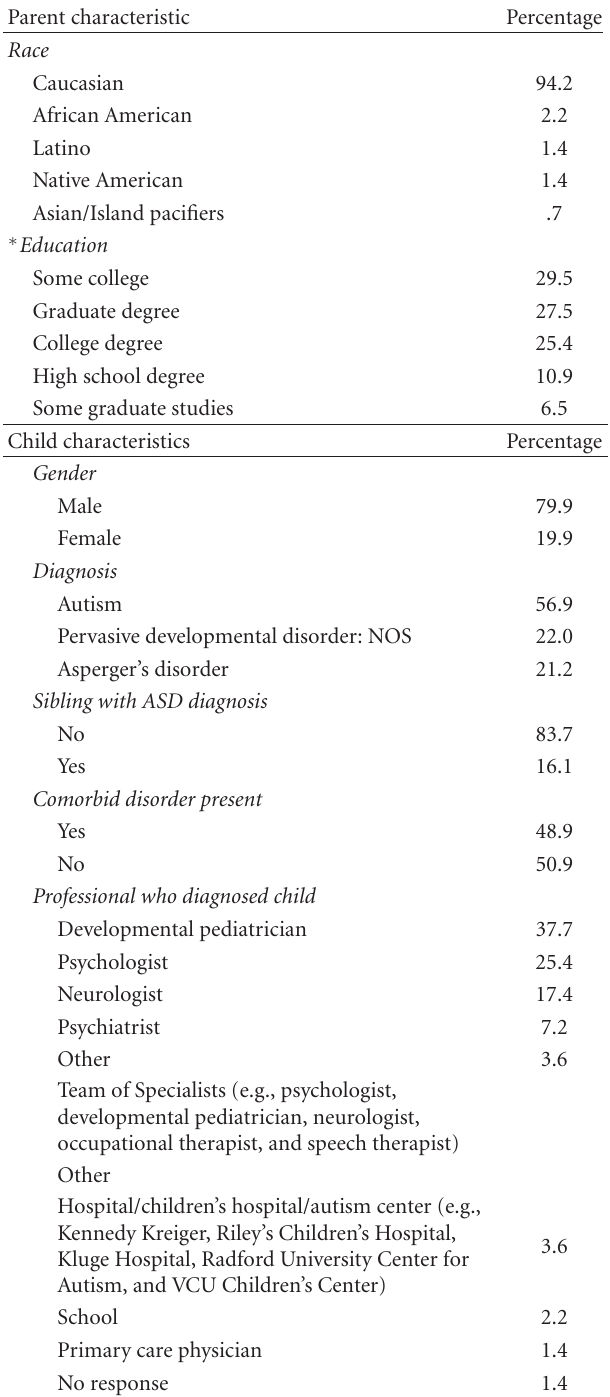
Table 1: Participant